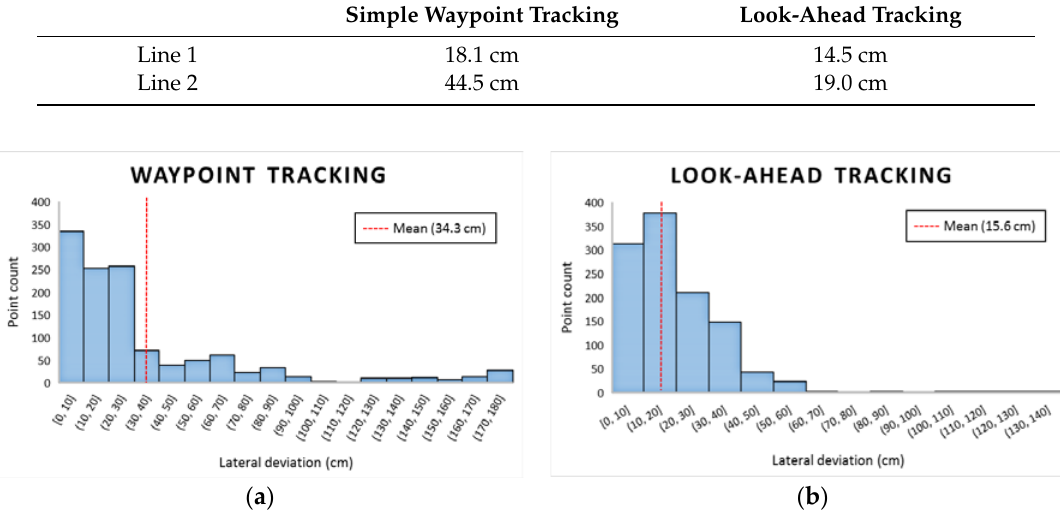
Figure 8. The histograms of lateral deviations from the waypoint tracking ( a ) and look-ahead tracking ( b ) methods.